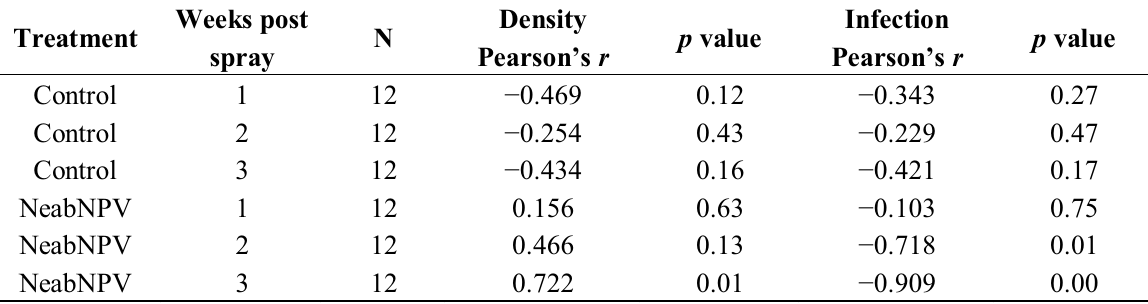
Table 1. Island Pond 2002. Summary of Pearson correlation analyses showing weekly trends in the relationship between distance from the treated (NeabNPV) or untreated (control) blocks and juvenile sawfly densities and the prevalence of NeabNPV infection in juvenile balsam fir sawfly